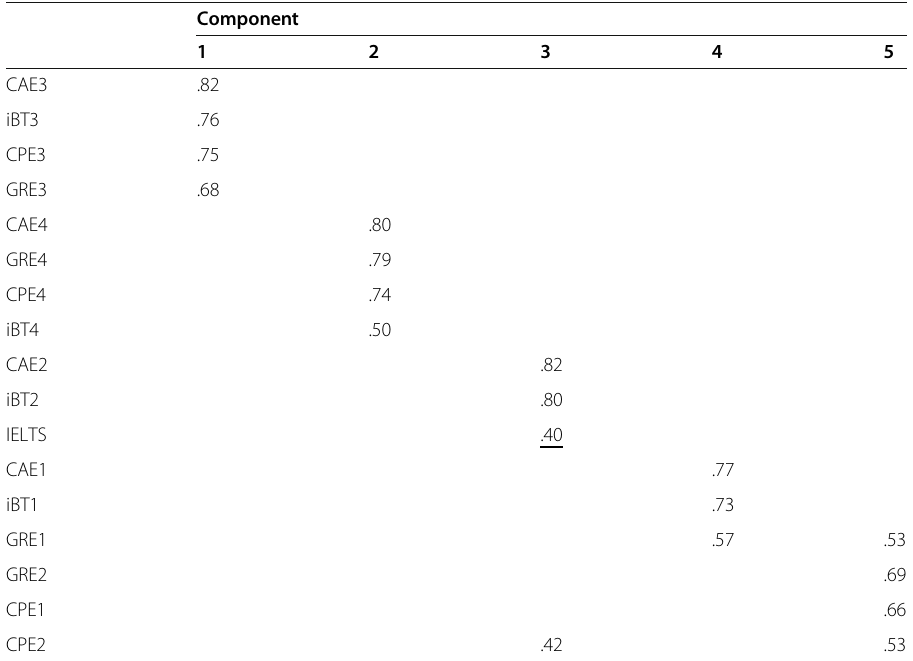
Table 8 Rotated component matrix